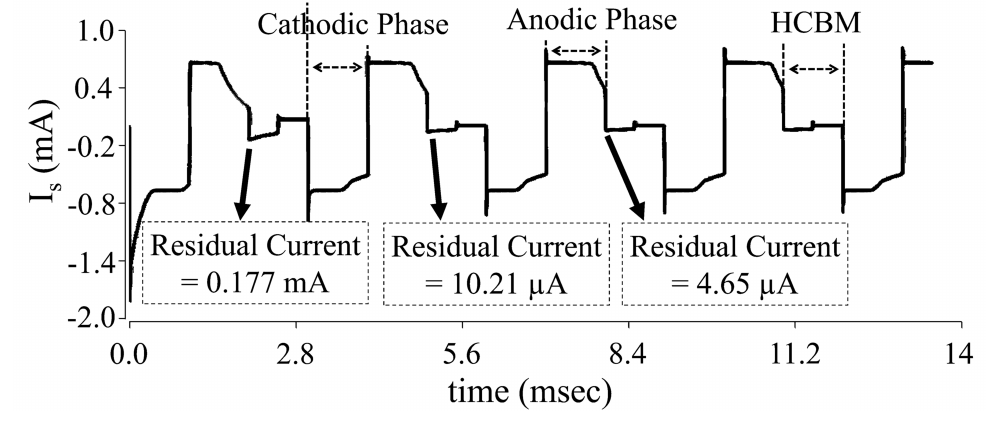
Figure 10. Stimulation current across load.